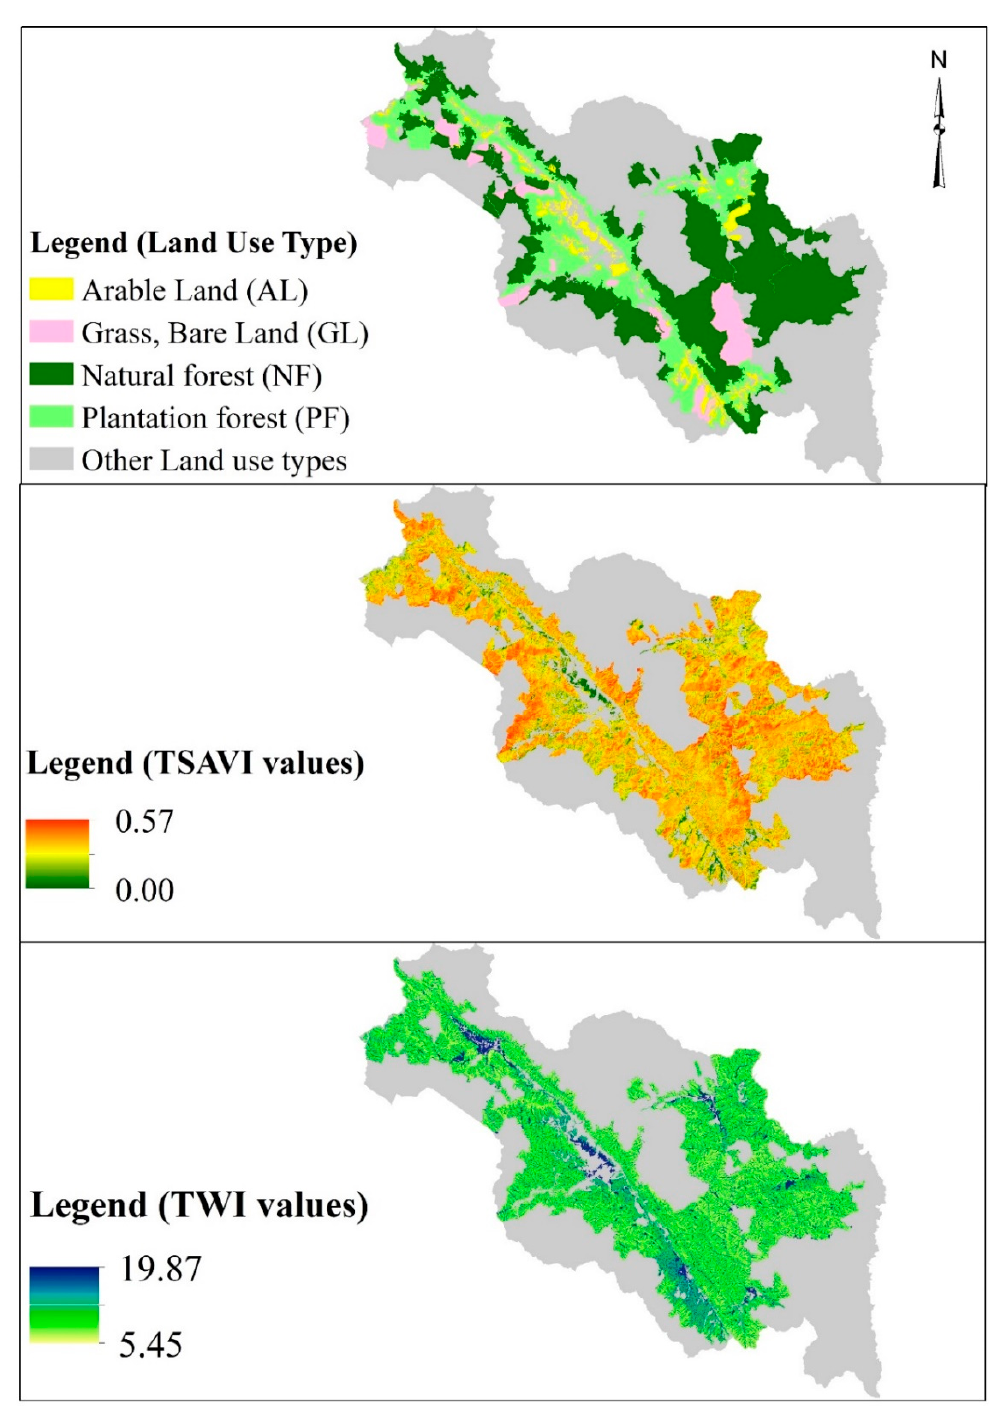
Figure 3. Map of environmental variables.